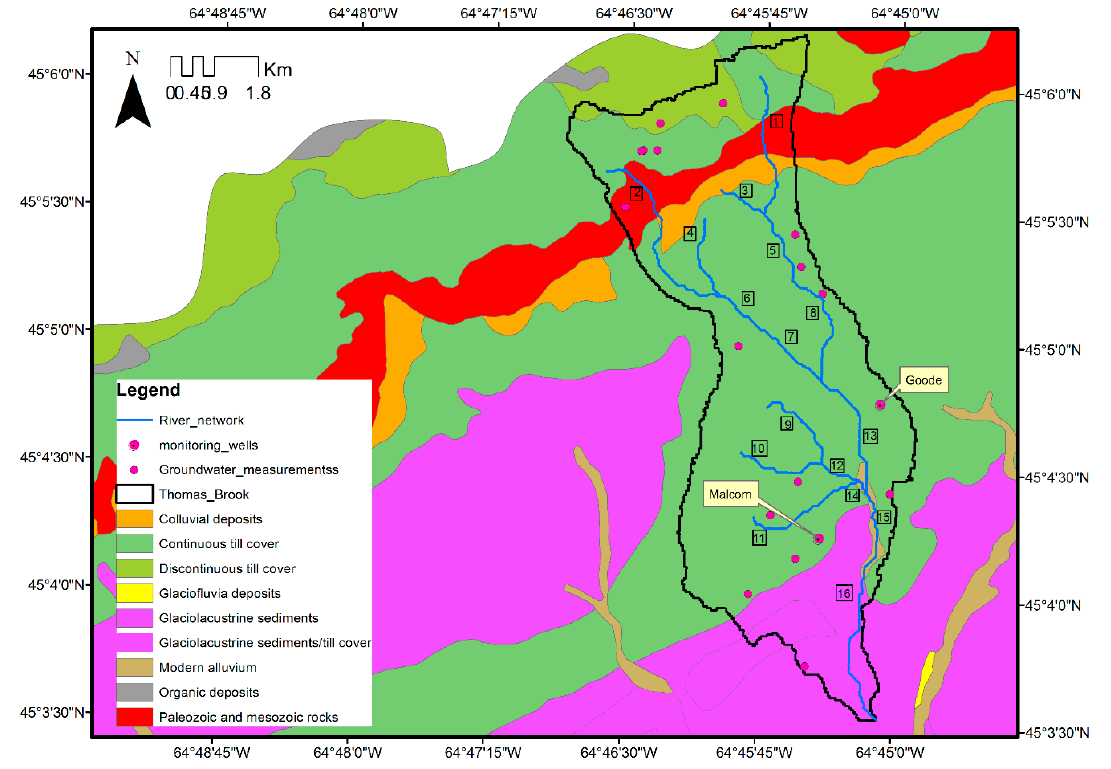
Figure 3. Surficial formations in the Thomas Brook catchment (modified after [17]). The number in rectangle box represents the reach numbers.